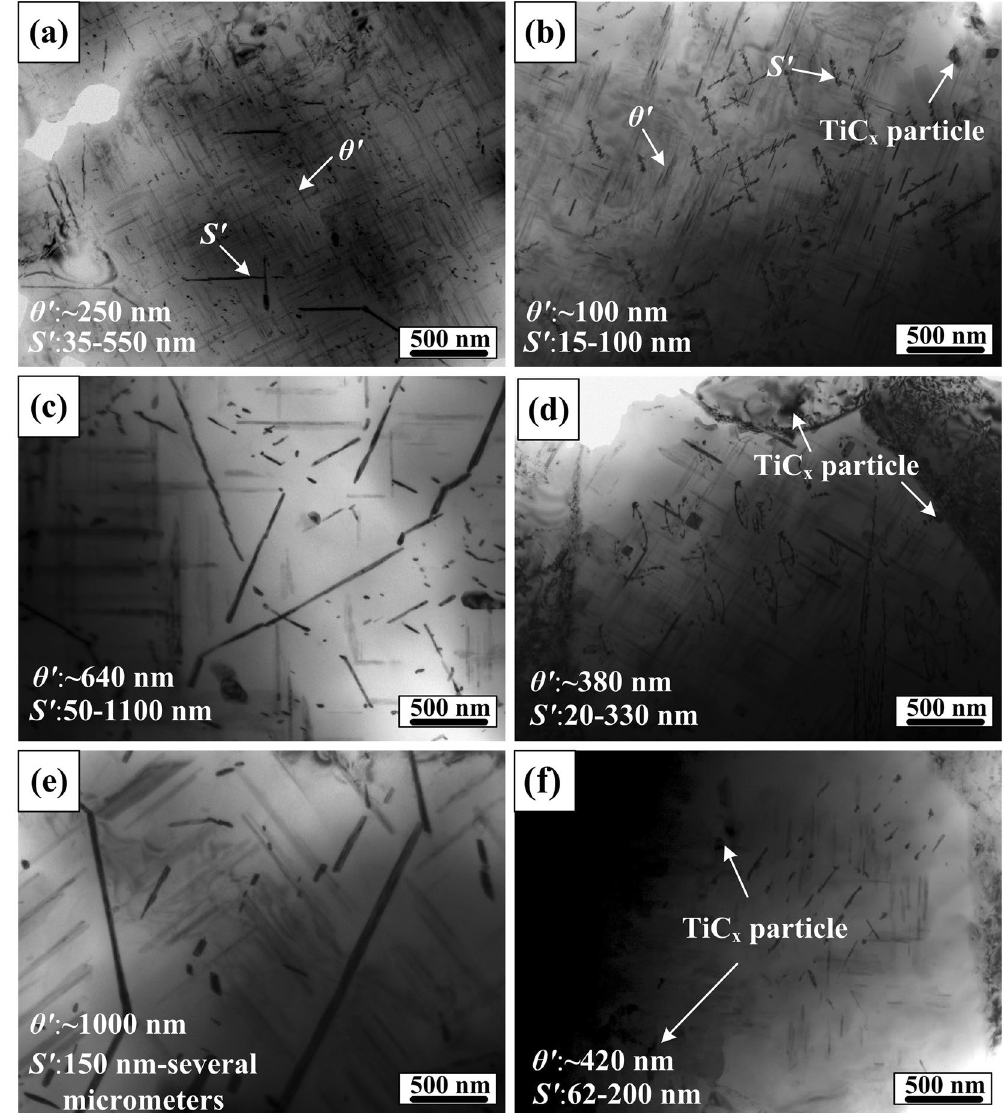
Figure 9. TEM images of θ ′ and S ′ precipitates in Al-Cu-Mg alloy and nano-sized TiC x /Al-Cu-Mg composite at various condition after tensile test: the ( a ) Al-Cu-Mg alloy and ( b ) the composite at 493 K, the ( c ) Al-Cu-Mg alloy and ( d ) the composite at 533 K as well as the ( e ) Al-Cu-Mg alloy and ( f ) the composite at 573